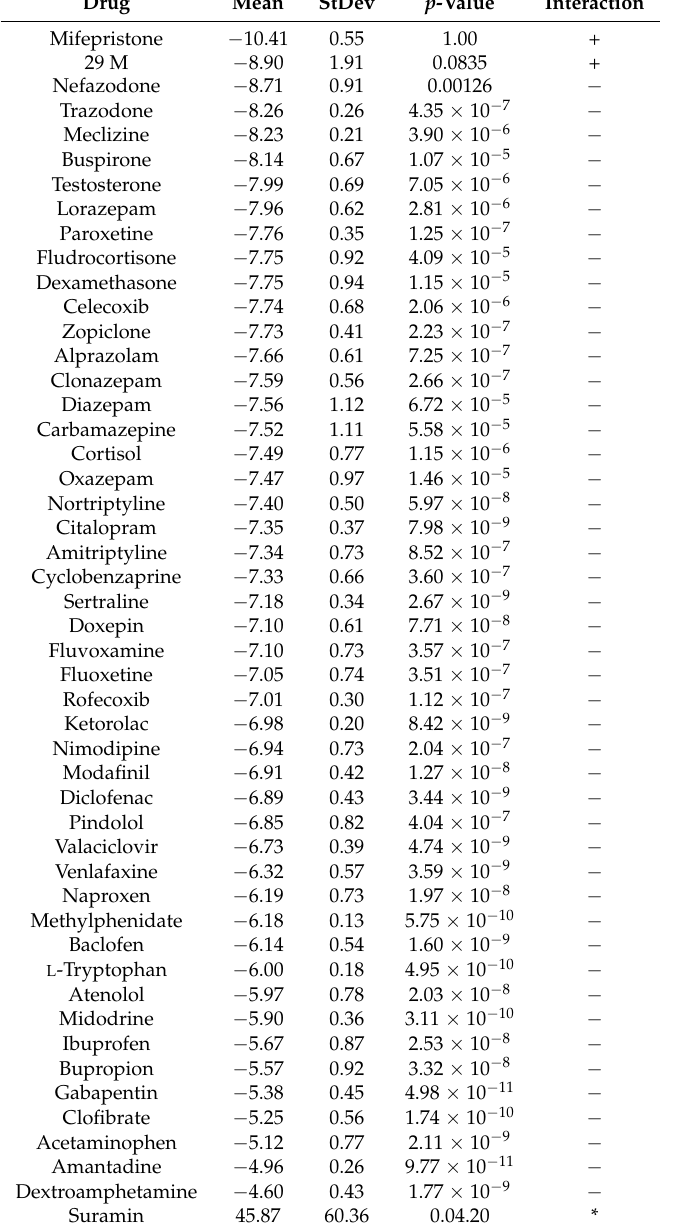
Table 3. Interaction of common drugs used to treat GWI symptoms with the GCR antagonist form. Mean binding energy and standard deviation are in units of kcal/mol. A t -test was used to compare to the known binder mifepristone. (+) indicates putative binding, ( − ) indicates no putative binding, (*) indicates more in-depth analysis